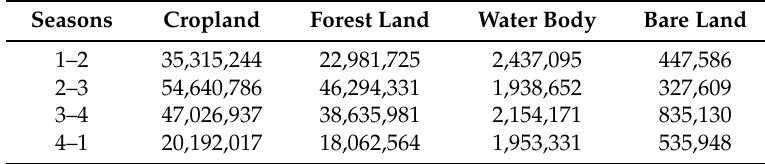
Table 9. Illogical pixels associated with four land cover types for the initial maps.